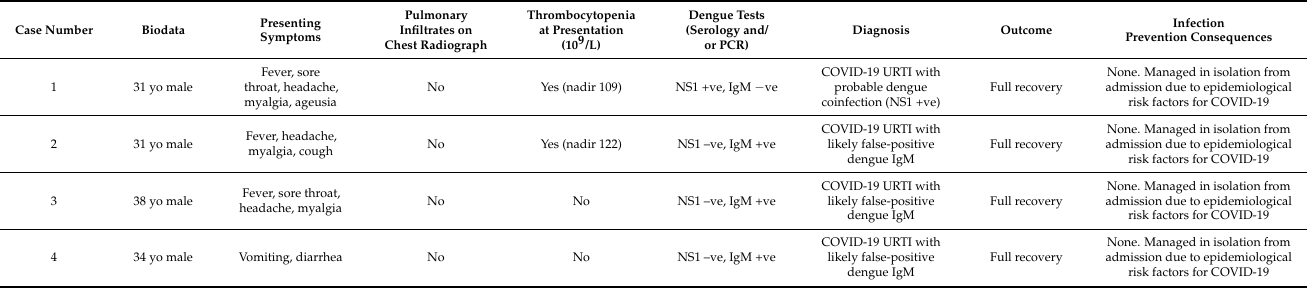
Table 1. Cases of PCR-proven COVID-19 infection with positive dengue serology at a Singaporean tertiary hospital during the COVID-19 pandemic,